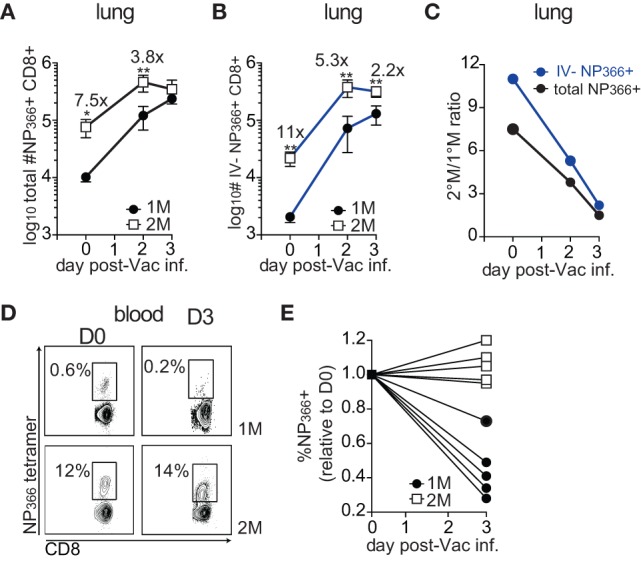
Early after the onset of the challenge infection 1°M CD8 T cell population in the infected lung undergoes dramatic increase. (A) Change in total numbers of NP366-specific CD8 T cells isolated from the lung (black line) or (B) from the lung parenchyma (blue line) on days 0–3 post-Vac-NP infection (n = 3–5 mice/group). Representative of two independent experiments. Error bars represent mean ± SEM. Unpaired t test; *p < 0.05, **p < 0.01. (C) Ratio between numbers of NP366-specific 2°M and 1°M CD8 T cells isolated from the whole lung (black line) or lung parenchyma (blue line) calculated on days 0–3 post-Vac-NP infection. (D) Representative NP366-specific tetramer staining of cells isolated from peripheral blood of 1°M and 2°M CD8 T cell-bearing mice on D0 and D3 post-Vac-NP infection. Representative of two independent experiments. (E) Size of NP366-specific CD8 T cell population measured in peripheral blood of 1°M and 2°M CD8 T cell-bearing mice on D3 post-Vac-NP infection relative to the baseline measured at D0. Representative of two independent experiments.